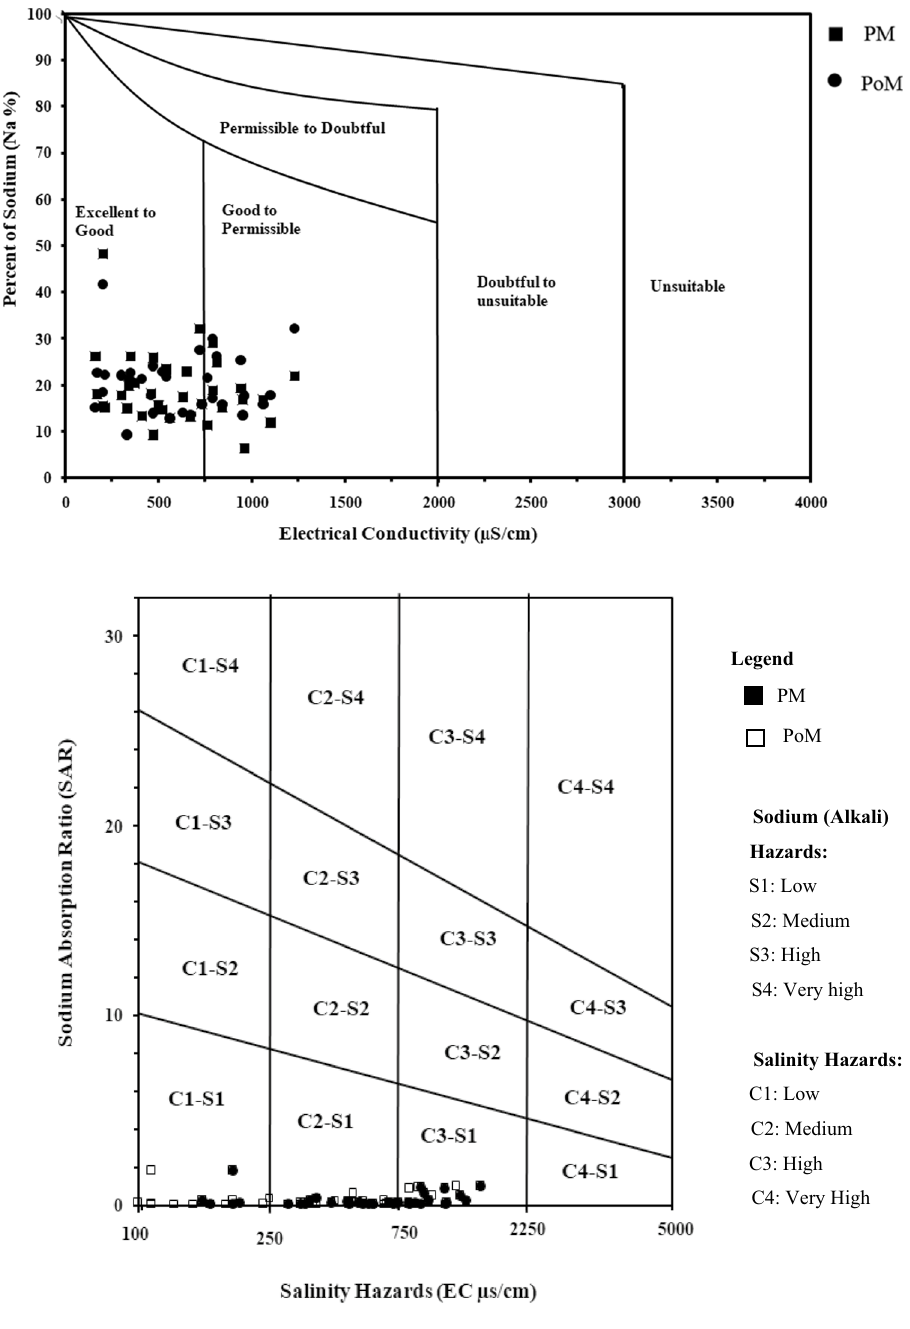
Fig. 8 Wilcox diagram of indicating suitability of ground water quality for irrigational use during both PM and PoM seasons